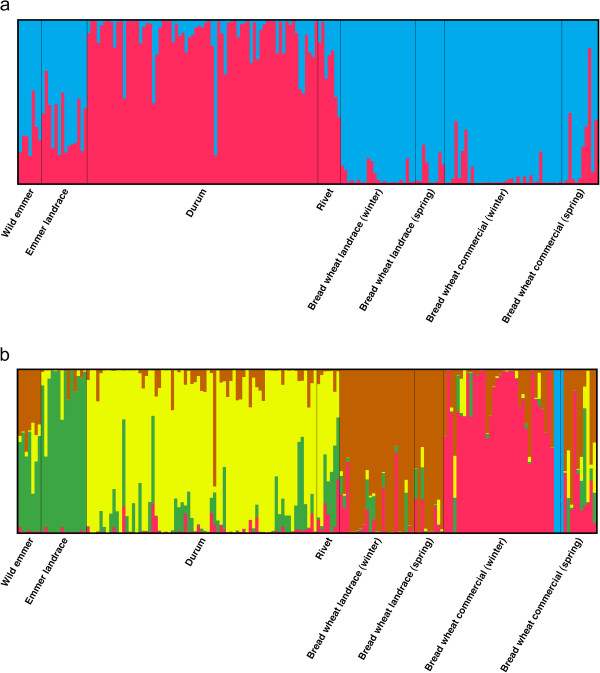
Results of Principal Component Analysis of all wheats (excluding Yumai 34, Anahuac 75 and Ukrainka 3). Black = wild emmer; purple = landrace emmer; red = durum; orange = rivet; blue = landrace bread wheat; green = commercial bread wheat a) First and second PCs, b) third and fourth PCs.